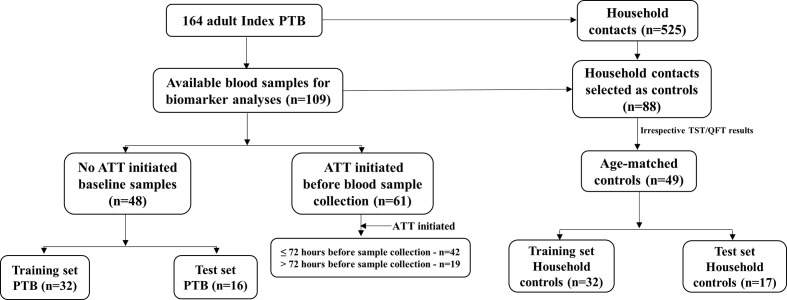
Study flow chart. PTB, pulmonary tuberculosis; ATT, anti TB therapy.